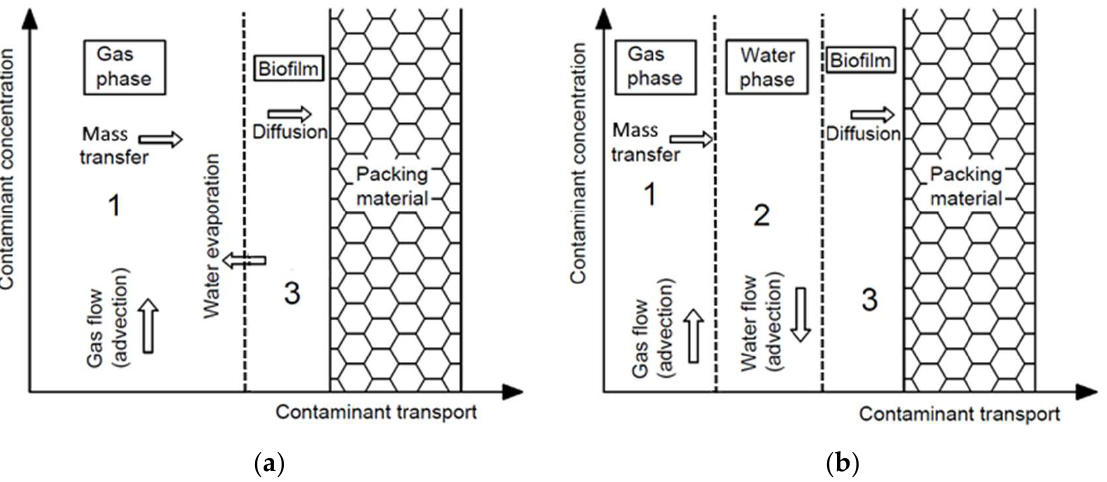
Figure 1. Biofiltration process in ( a ) a biofilter and ( b ) a biotrickling filter. 1: Contaminant transport in a gaseous phase; 2: contaminant transport in a liquid phase; and 3: contaminant biodegradation.